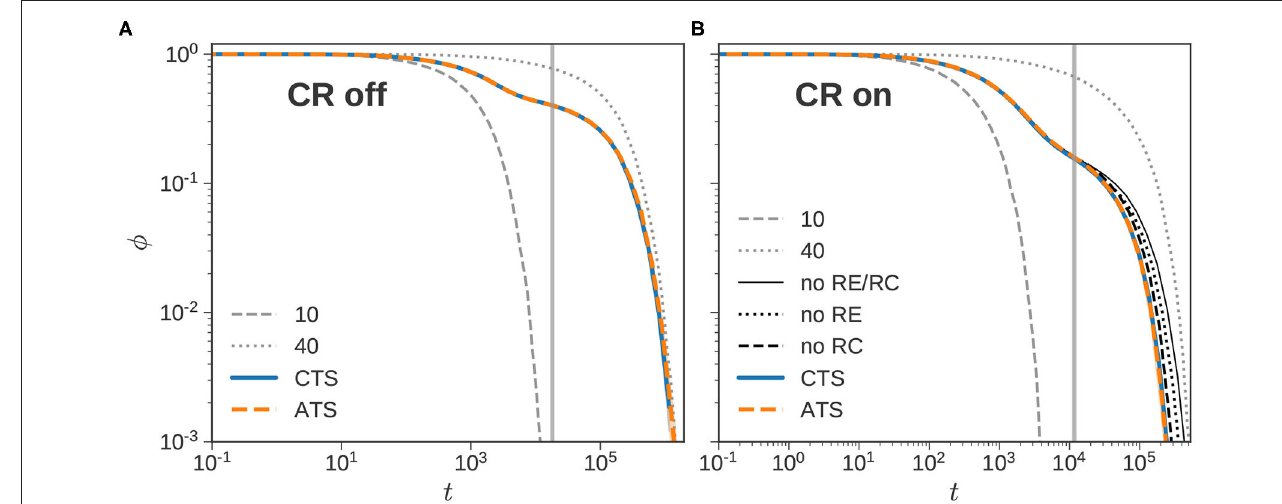
FIGURE 4 | CR switched off and on. Normalized stress relaxation of a bidisperse blend ( ¯ Z 1 = 10, ¯ Z 2 = 40) with w 1 = w 2 = 0.50 using the CTSA (solid blue) and ATSA (dashed orange). The dashed and dotted gray lines mark the normalized stress relaxation of the monodisperse ¯ Z = 10 and ¯ Z = 40 components, respectively. The vertical gray line marks τ ∗ 1 , when the stress associated with the short chains is completely relaxed. CR is switched off in (A) , but switched on in (B) , where the dashed, dotted, and solid black lines show the ATS calculation without RC, RE, and both RC and RE, respectively.